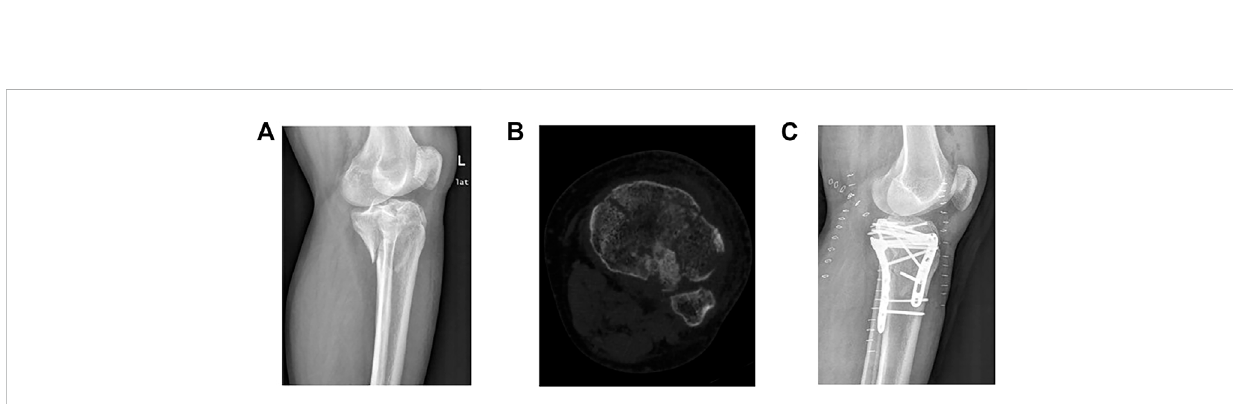
Comparison of the HSS (A) and Lysholm (B) scores between the control and observation groups. ** p < 0.01. HSS: Hospital for Special Surgery.